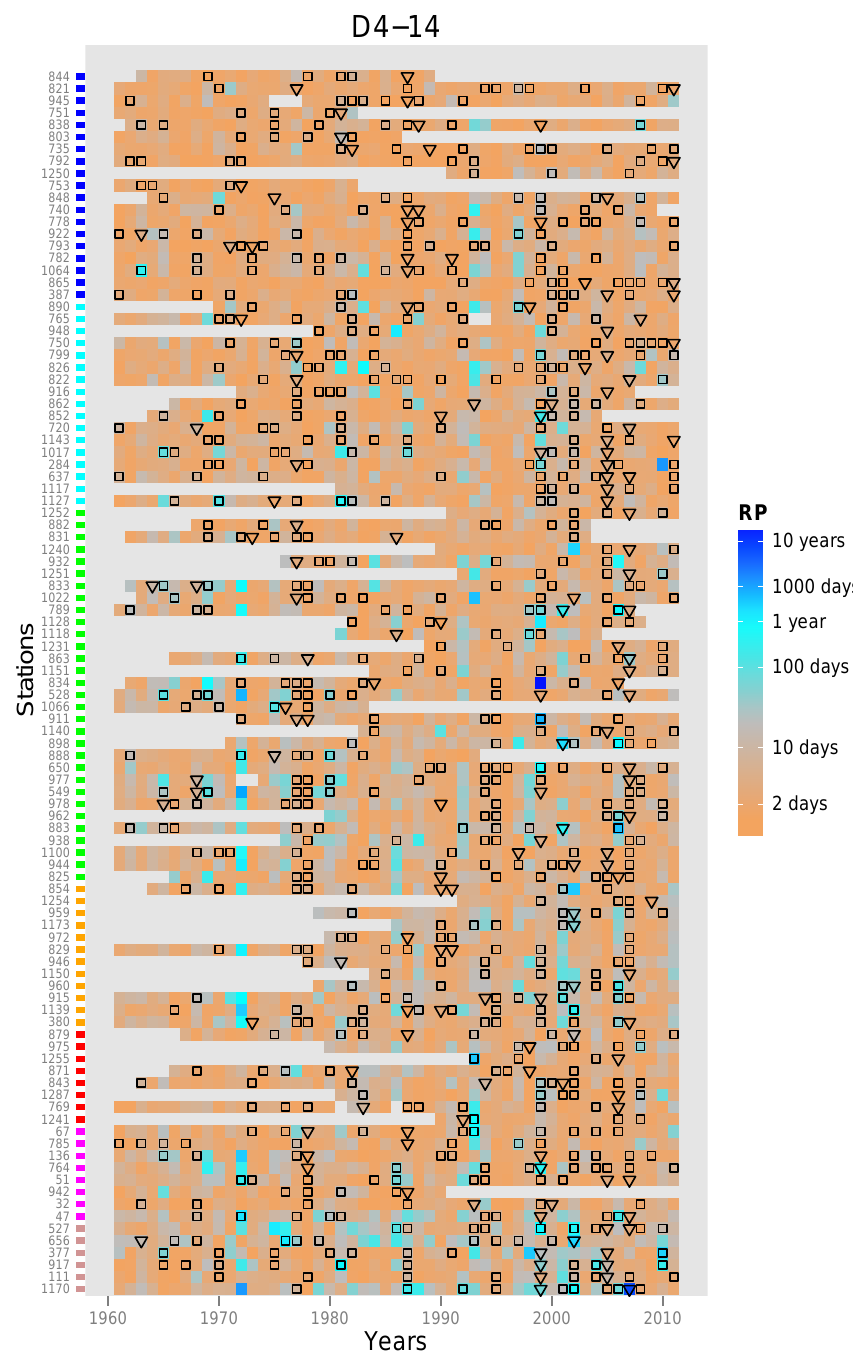
Figure 5. Same as Fig. 4 but for PRE-AP